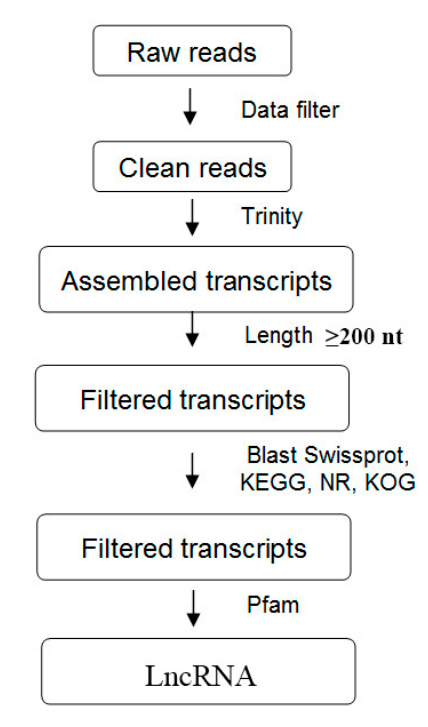
Figure 1. General flowchart of the pipeline used to systematically identify long non-coding RNAs (lncRNAs) in Nicotiana benthamiana infected with Chinese wheat mosaic virus.